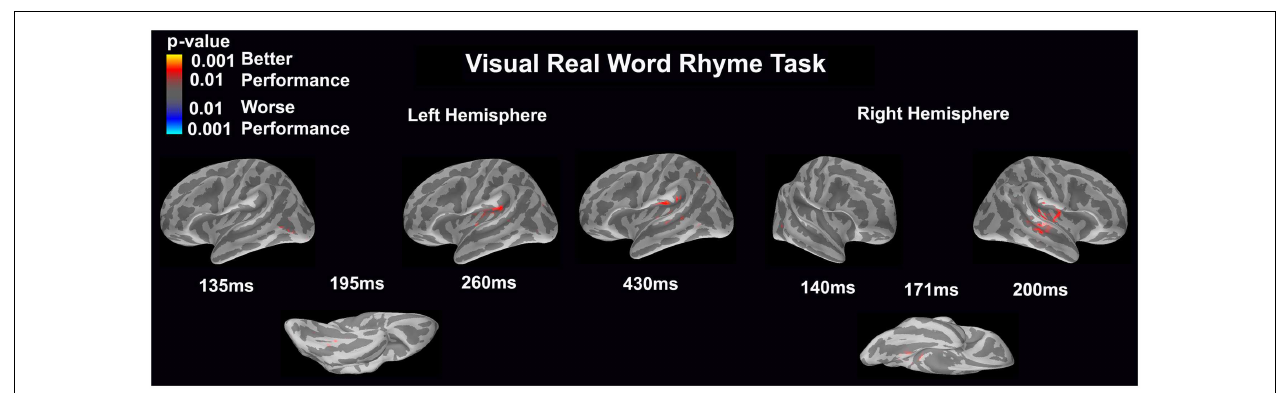
associated with worse performance. Performance was based on the individual participant’s real word reading ability as indexed by the scaled score on theWoodcock–Johnson III Letter–Word Identification